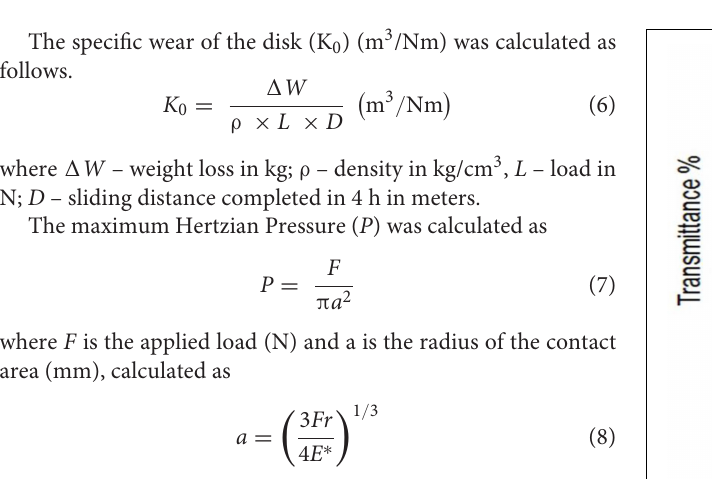
FIGURE 3 | Configurations in (A) adhesive wear, (B) abrasive wear, and (C) erosive wear.